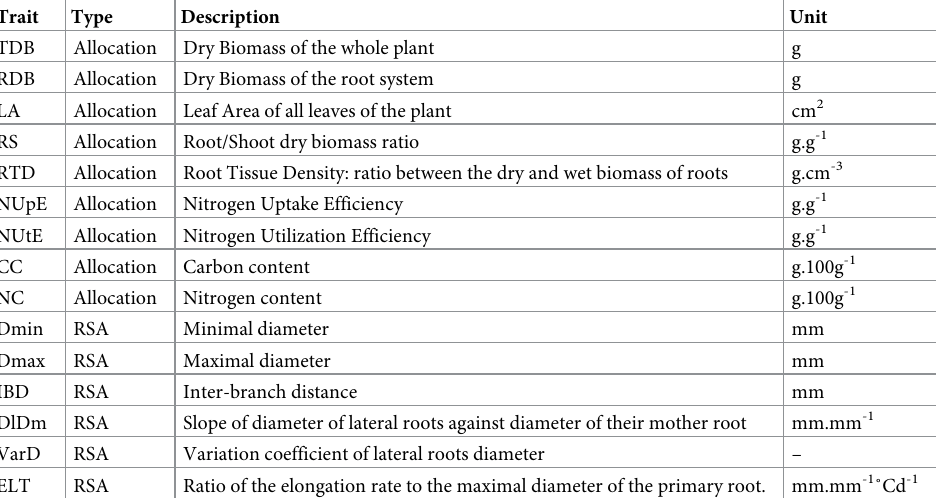
Table 2. List of all the traits measured or calculated at the end of the experiment. Trait